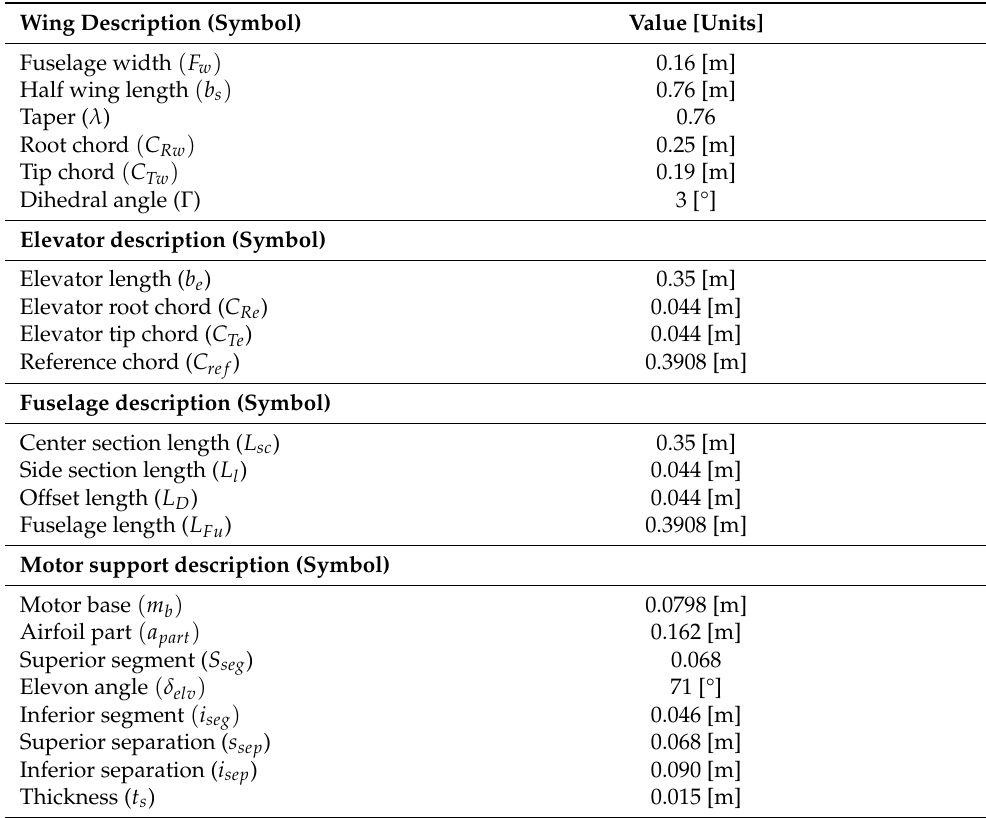
Table 1. Dimensions of tail-sitter wing.